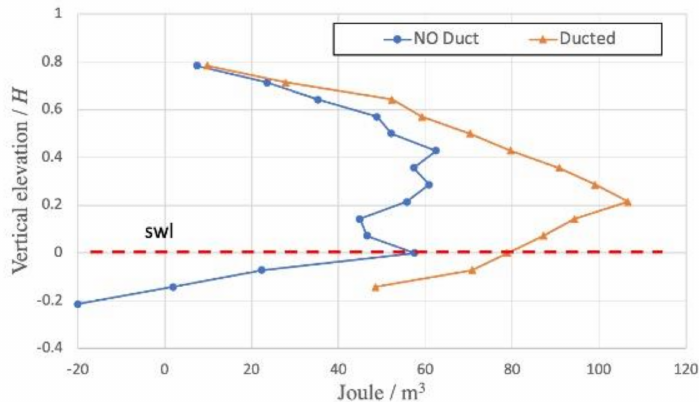
Figure 14. The energy per m 3 of water comparison between the no duct case (blue circle) and the ducted case (orange triangle) at the breaking wave zone.